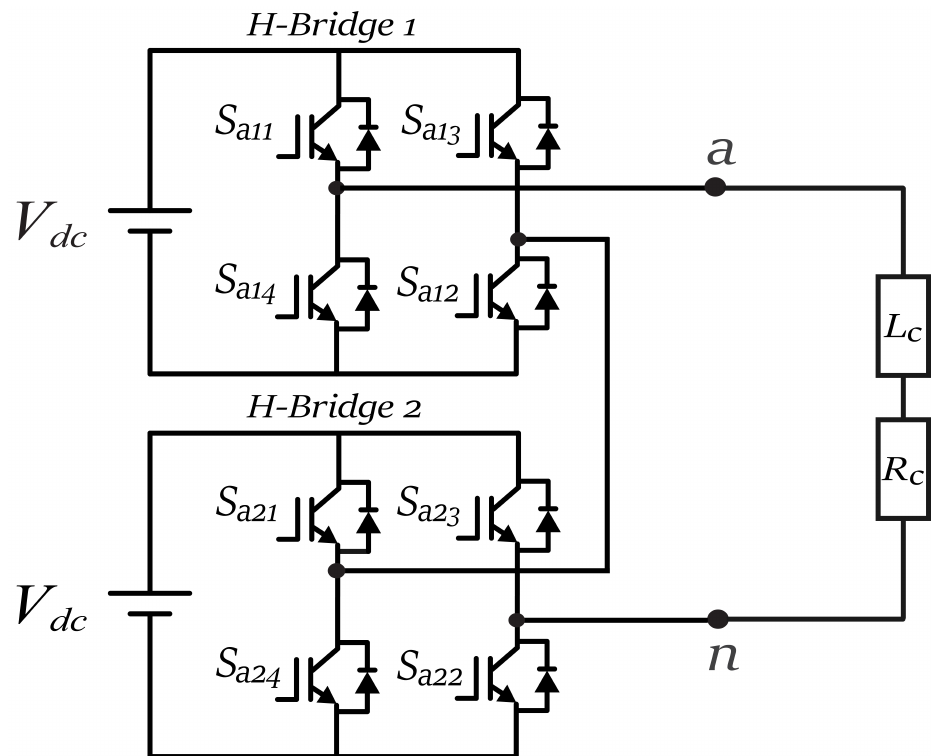
Figure 5. Equivalent circuit of asynchronous induction coil launcher, which is driven by 5-level CHB